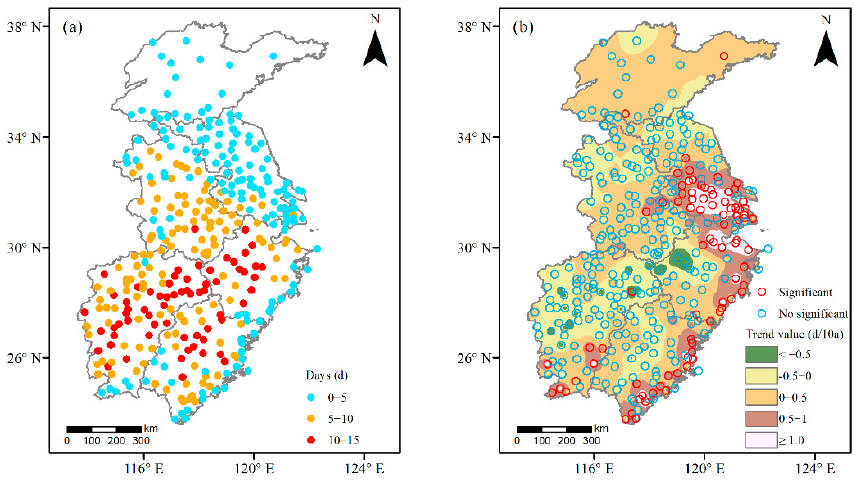
Figure 8. ( a ) Mean maximum consecutive extreme maximum temperature event days, and ( b ) climate tendency rate and significant variation distribution of these days in East China during the period 1961–2020. Table 2. Mann–Kendall test of maximum consecutive extreme maximum temperature event (EMTE).